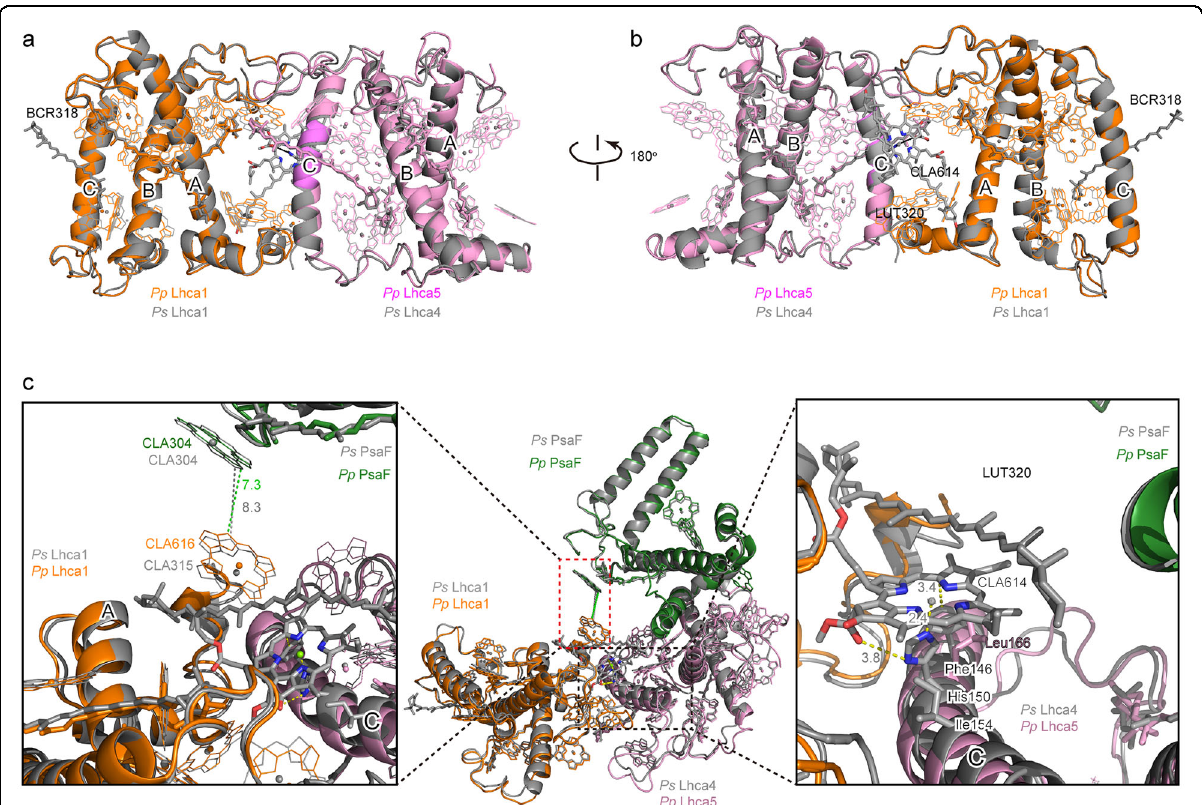
Fig. 5 Structural comparison of Lhca1 – Lhca5 dimer from P . patens with Lhca1 – Lhca4 dimer from P. sativum . a Superposition of Pp Lhca1 – Lhca5 with Ps Lhca1 – Lhca4 viewed along the membrane from the Lhcas side to the PSI core side. b View along the membrane from the PSI core side to the Lhcas side. c Structure of Lhca1 – Lhca5 – PsaF from P . patens , showing the interactions between Lhca1 – Lhca5 dimer and PsaF and the comparison with the corresponding part from P . sativum . Color codes and PDB ID codes: P . patens , Lhca1, orange; Lhca5, violet; Lhca2, limon; Lhca3, lightblue; 6L35; P . sativum , all subunits in gray,